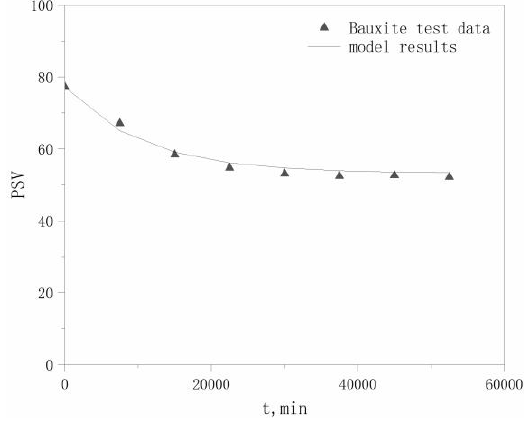
Figure 4. Modeled and tested PSV Results for calcined bauxite. Fig. 4 Modeled and tested PSV Results for calcined bauxite. Fig. 5 Modeled and tested PSV results for granite.